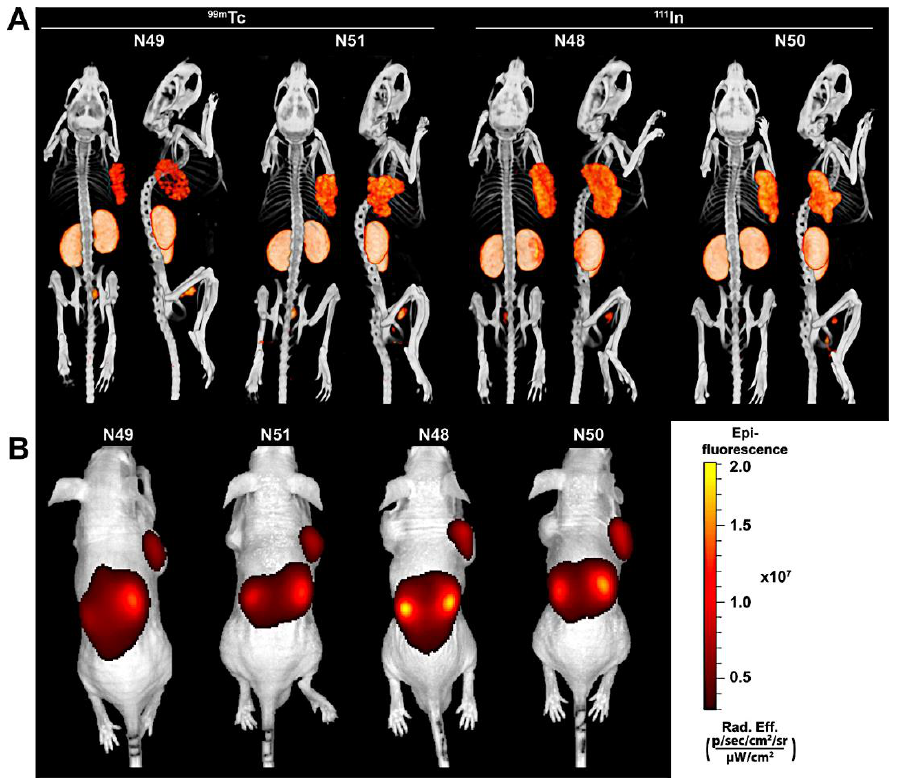
Figure 11. The ligands visualise PSMA-positive tumours using µ SPECT/CT and fluorescence imag- ing. The panels display ( A ) µ SPECT/CT scans, ( B ) Fluorescence images of mice with LS174T-PSMA (right) and wild-type LS174T (left) tumours after intravenous injection of 111 In (10 MBq/mouse) or 99m Tc-labelled (15 MBq/mouse) ligands. Reprinted with permission from Ref. [71]. Copyright 2022 American Chemical